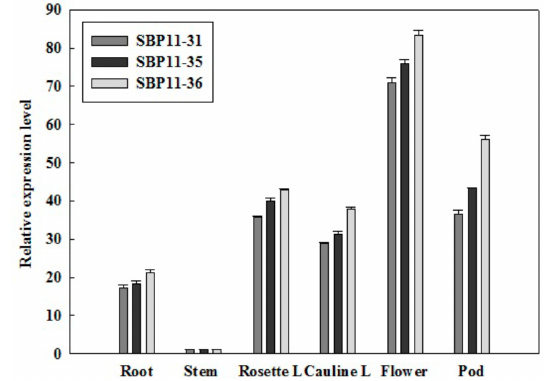
Figure 5. Phenotype of VpSBP11 transgenic plants. ( A ) Wild-type (WT) plant compared with VpSBP11 transgenic lines after 21 days of growth under long-day conditions. The transgenic plants flowered earlier and formed fewer leaves; ( B ) The rosette and cauline leaves of the VpSBP11 transgenic lines were strongly curled. Red arrowheads in ( A ) and ( B ) indicate the strongly curled leaves of the transgenic plants; ( C ) The number of leaves without abaxial trichomes (black), with abaxial trichomes (gray), and with cauline leaves (white) of three VpSBP11 transgenic lines (SBP11-31, SBP11-35, and SBP11-36) ( n > 30); ( D ) Representative blade petiole lengths of rosette leaves of the VpSBP11 transgenic lines. The red lines visually indicate the length of the representative blade petiole; ( E ) Petiole lengths of rosette leaves of the genotypes illustrated in ( A ) (21 days, n = 50 for each genotype, * p < 0.05, ** p < 0.01, one-way ANOVA). The experiments were repeated three times with consistent results.